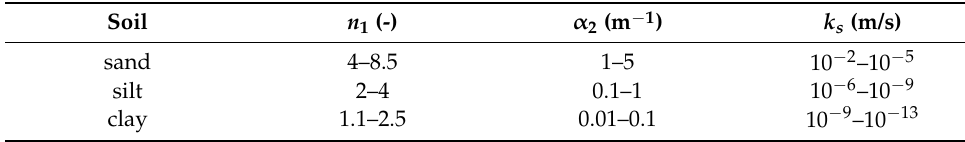
Table 2. Hydraulic properties of various